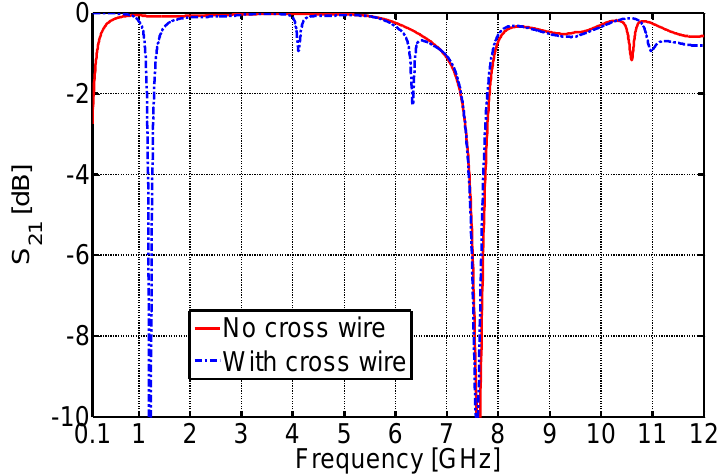
Figure A2. Comparison of gap-transmission characteristics for the cases with and without cross wire ( R ’ = 15 mm; acetal homopolymer).